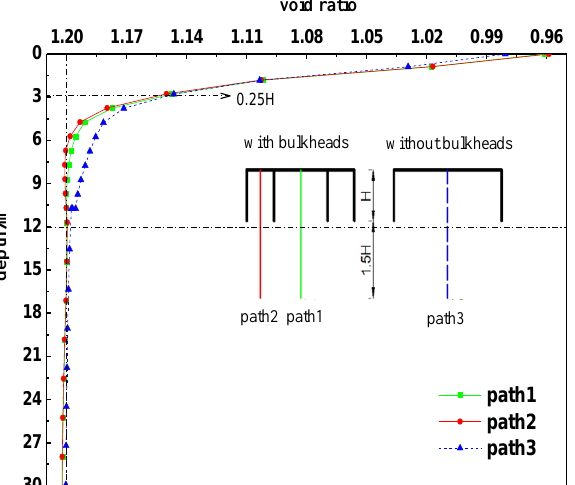
Figure 11. Void ratios with soil depth along different paths.